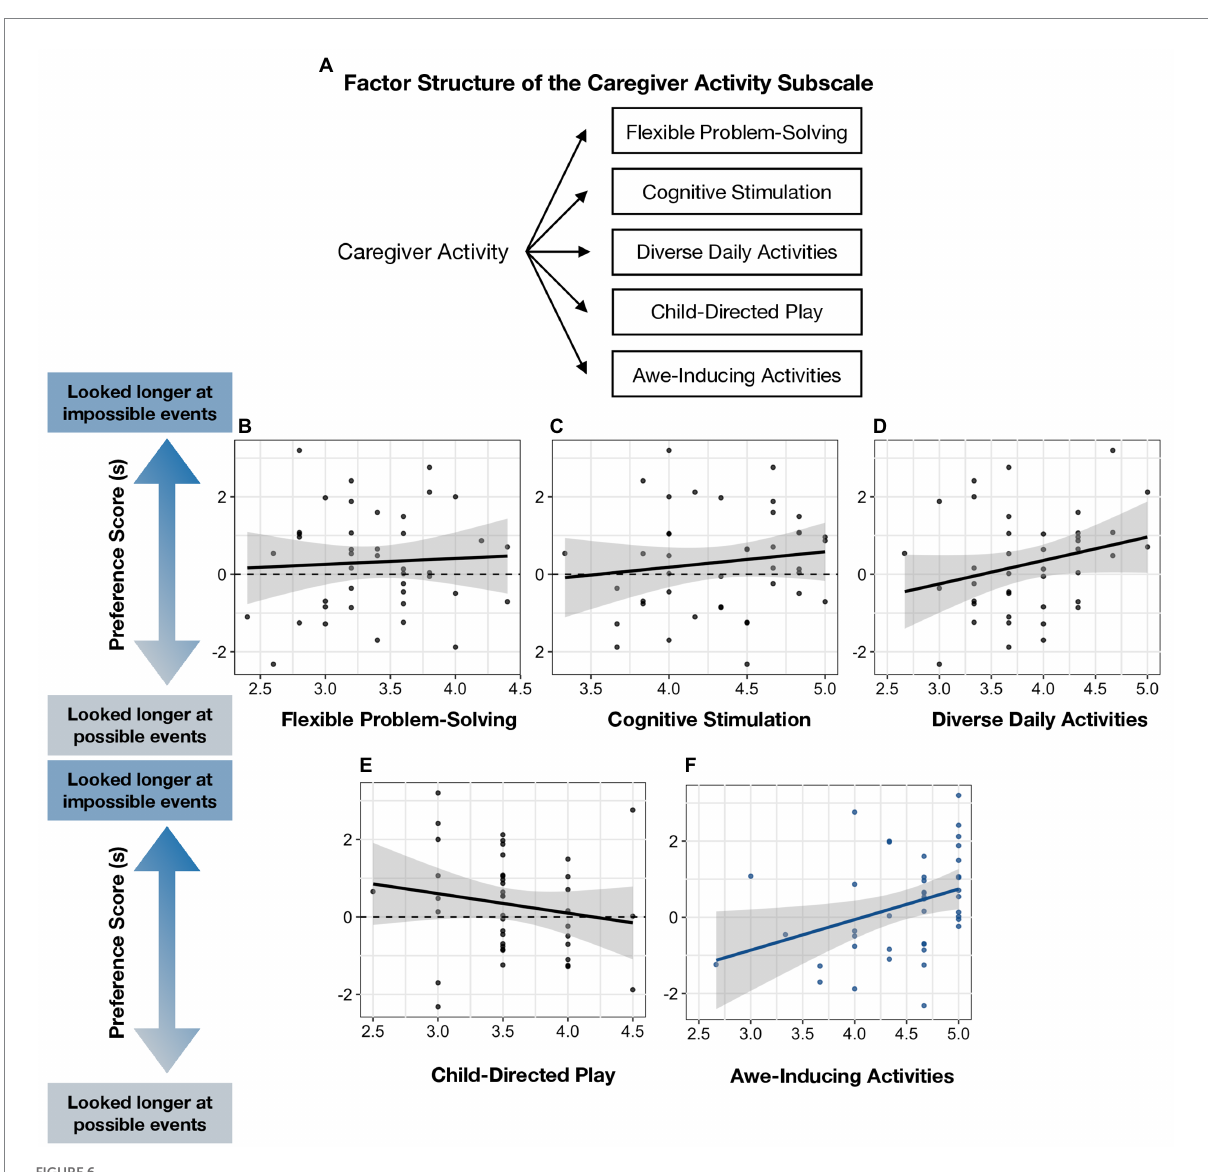
FIGURE 6 (A) Factor structure of Caregiver Activity Subscale and (B–F) relation between five factors and infants’ Preference Score.